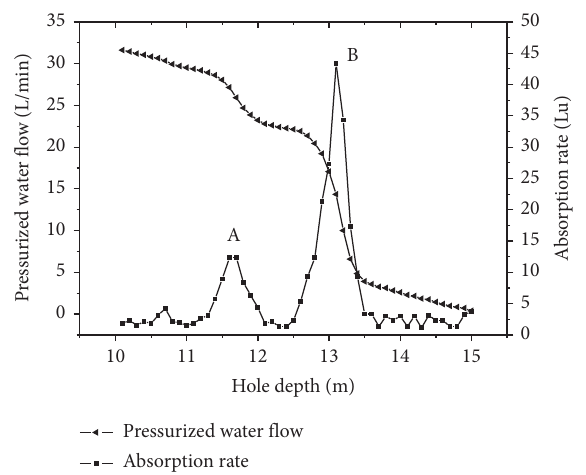
Figure 6: Distribution curves of pressurized water flow and ab- sorption rate with the pumping hole